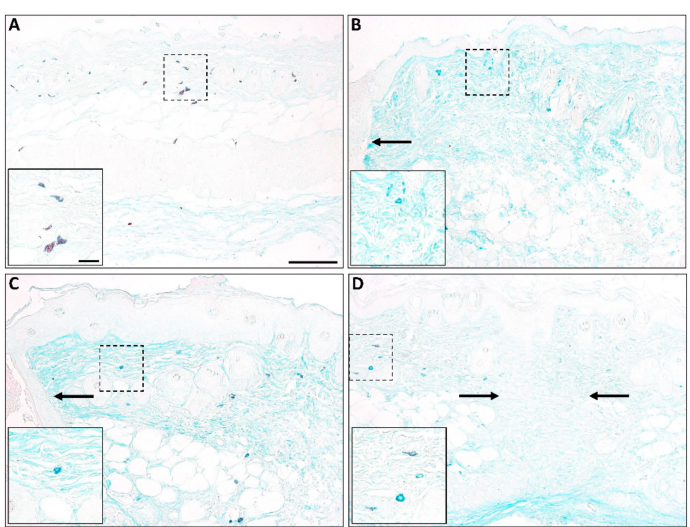
Figure 3. Mast cells in murine wounds. Alcian blue-safranin staining of murine skin ( A ) and wounds at 1 day ( B ), 3 days ( C ), or 7 days ( D ) post-injury shows changes in mast cell maturity during healing (blue staining = immature; red staining = mature). High numbers of mature mast cells are found in unwounded skin, followed by mostly immature mast cells at early times post-injury. By 7 days, mast cells with some red granules begin to appear. Insets show a high magnification view of the boxed area; arrows show the wound edge ( B , C ) and healed wound margin ( D ). Scale bar = 100 µ m; Inset scale bar = 20 µ m.